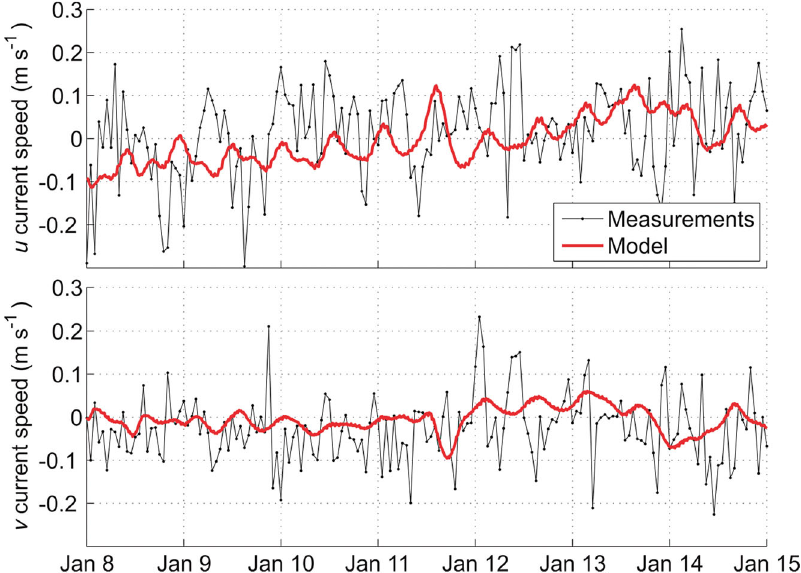
Fig. 5. Comparison of measured (thin black line) and simulated (thick red line) currents at 14.5 m depth along the model’s 2 component directions, u and v , at the Seawatch buoy (labelled SWB in Fig. 1B). For SINMOD, hourly data from the 12 to 15 m depth layer are shown, disregarding elevation, covering the period 8 to 15 January 2012. Measurements were made hourly